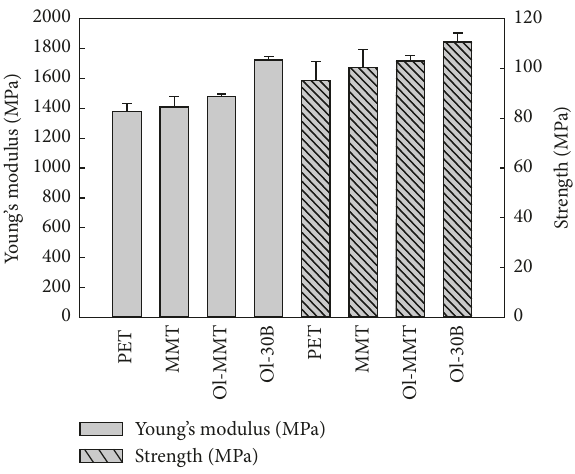
Figure 13: Strength of the sidewall of stretched blown PET and nanocomposite bottles.